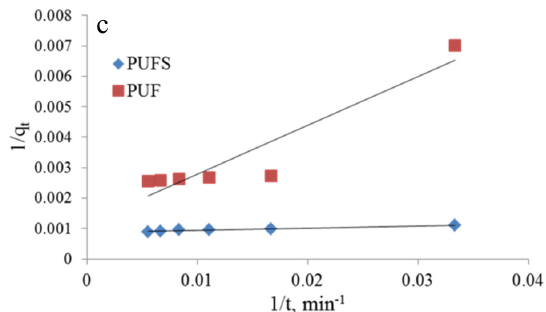
Figure 11. ( a ) Pseudo first-order, ( b ) pseudo second-order and ( c ) Ritchie’s second-order kinetic models for the sorption of CPF onto white PUF and PUFS.